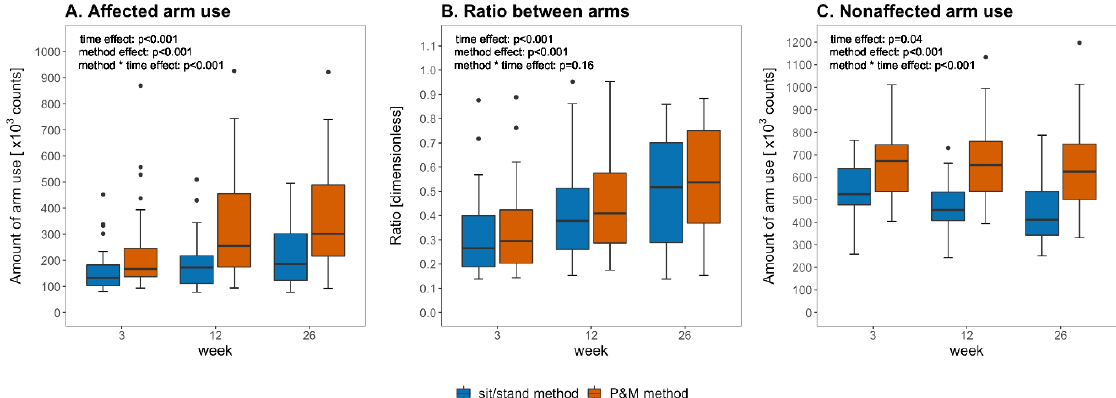
Figure 3. Boxplots showing the arm use outcomes of the P&M method and the sit/stand method at week 3, 12, and 26 poststroke. p -values of the GEE analyses are included in the plots.